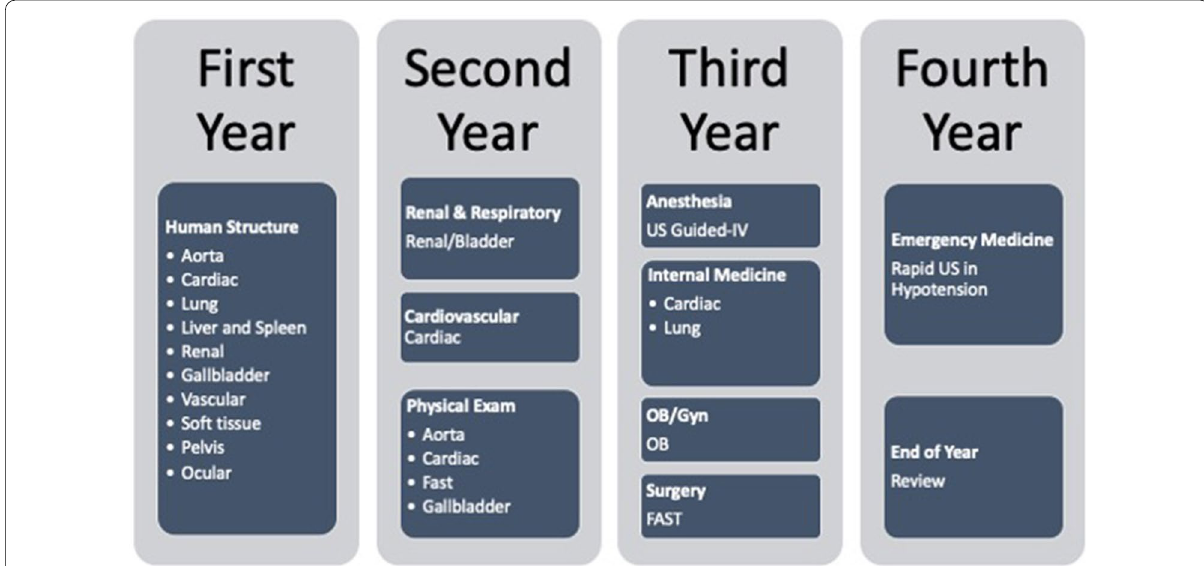
Fig. 2 Undergraduate medical education curriculum showing where POCUS modules were implemented, specifically in which year of schooling and in what